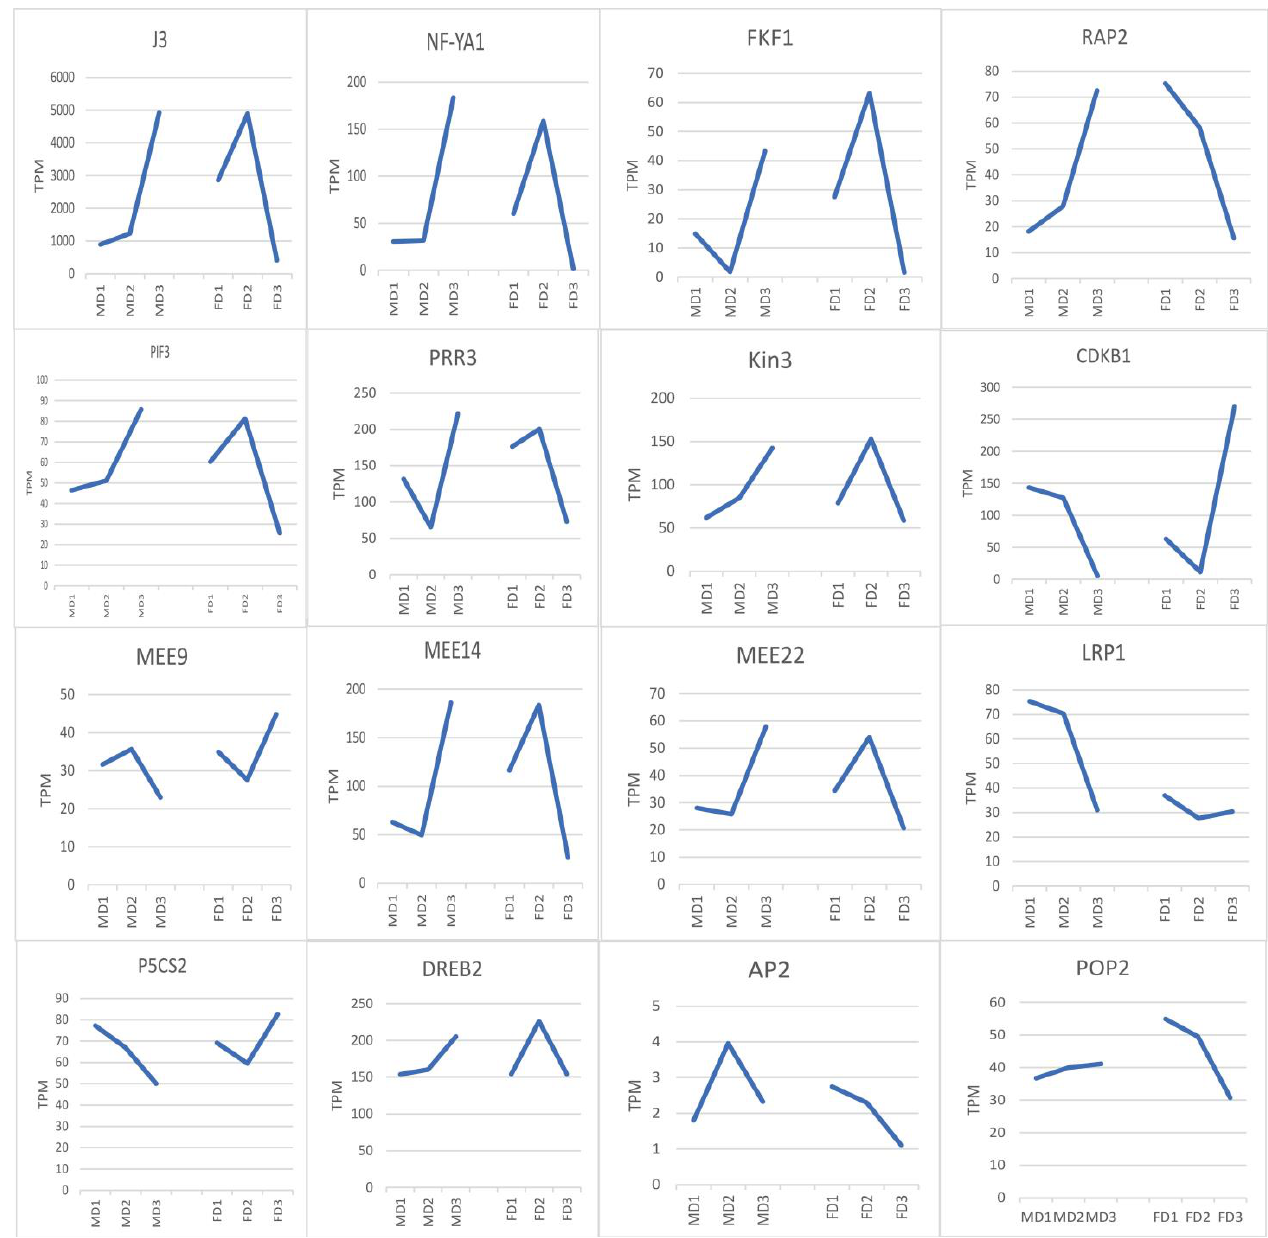
Figure 13. The expression trend of reproductive-related genes of male and female flower bud development in different stages. The expression trends of some genes were opposite during the development of male and female flower buds, suggesting that they may play different roles in the development of male and female flower buds. The vertical and horizontal axes are the average TPM values and male and female flower bud stages. TPM, transcripts per million; MD1, male flower buds’ initial differentiation stage; MD2, formation of male flower primordial stage; MD3, formation of the stamen primordia stage; FD1, female flower buds’ initial differentiation stage; FD2, formation of female flower primordial stage; FD3, formation of the pistil primordia stage.